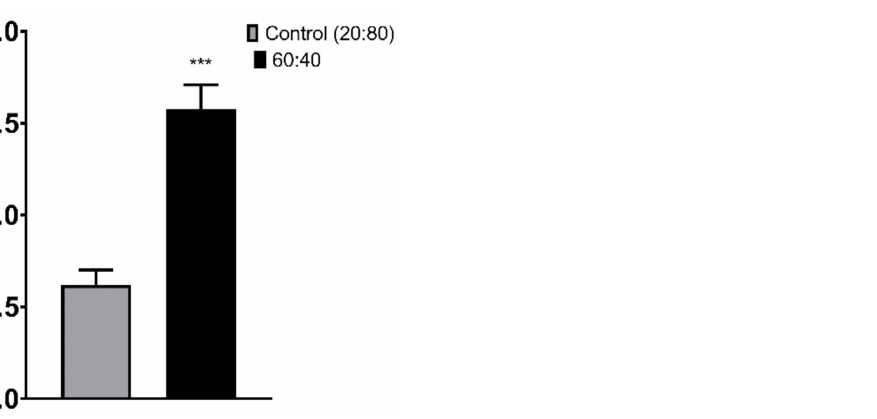
Figure 3. 24-h intake of individually presented Control 20:80 and 60:40 whey:casein formulation. *** p ≤ 0.001.